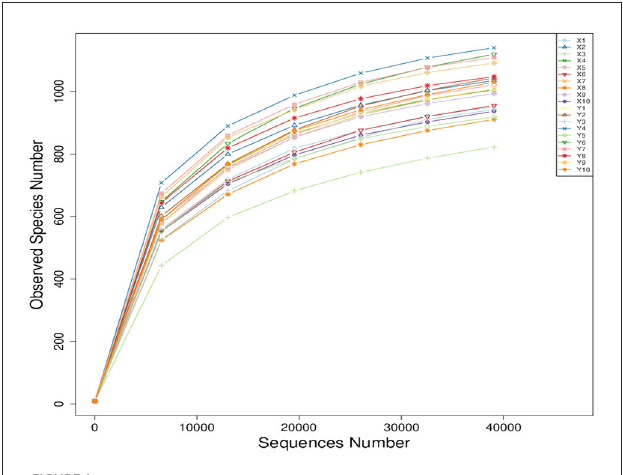
FIGURE1 Sample-based rarefaction curve of observed species.